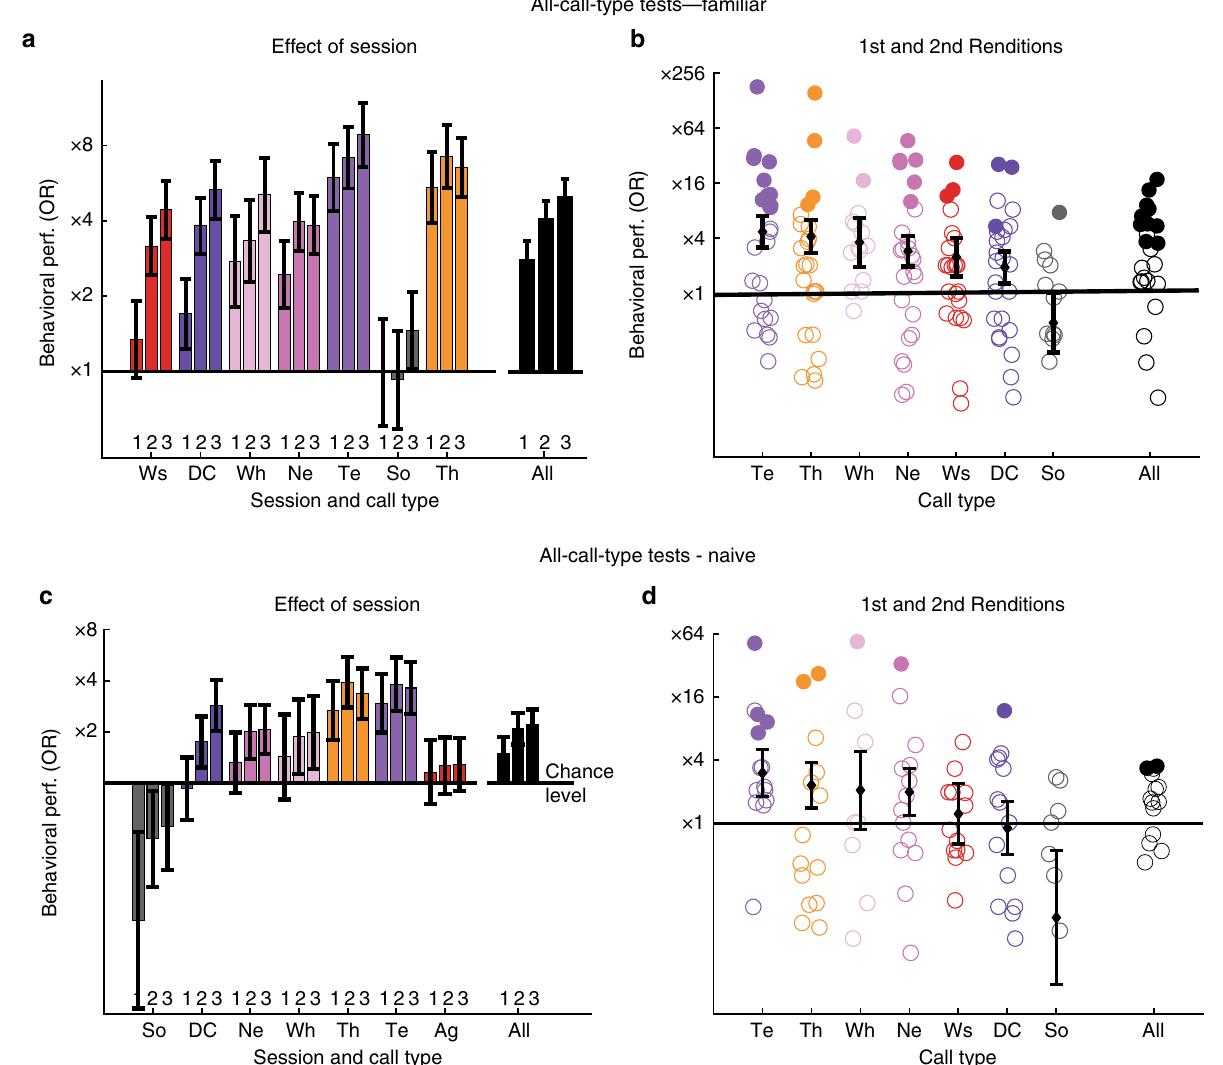
Fig. 7 Behavioral generalization across renditions in all-call-type tests. Effect of gain of experience with the sounds over the course of a daily test on behavioral performance where discrimination for vocalizer is assessed for all call types simultaneously. a , b show the results when subjects ( n = 13) are familiar to the vocalizers (same vocalizers as in single-call-type tests). c , d show the results when subjects ( n = 7) are naive to the vocalizers. a , c Behavioral tests were divided into three consecutive 30-min sessions labeled 1 − 3 (see Supplementary Methods). Call types are ordered along a decreasing effect of session from left to right. For both Familiar and Naive subjects, the OR increases with session rank (effect of Session:VocType: LRT on GLME for Familiar, χ 2 2 = 59.5, p = 1.2035×10 − 13 ; for Naive, χ 2 2 = 17.035, p = 1.9996×10 − 4 ). a Despite the behavioral improvement due to session training, the